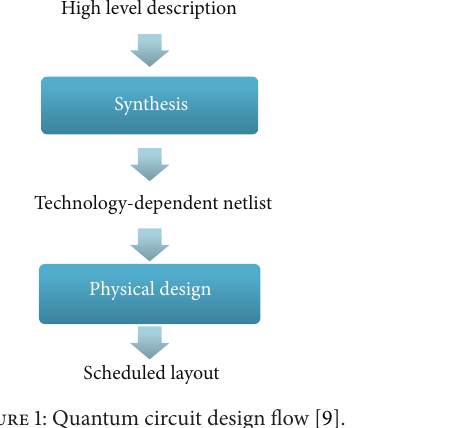
Figure 1: Quantum circuit design flow [9].